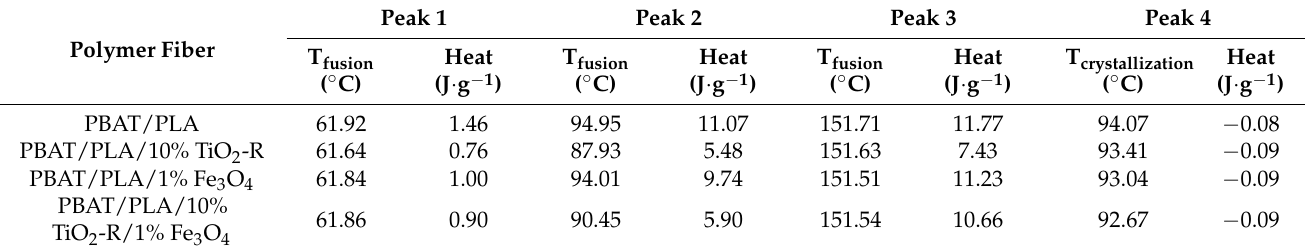
Table 5. Temperatures and heat involved in the fusion and crystallization of polymer fibers.